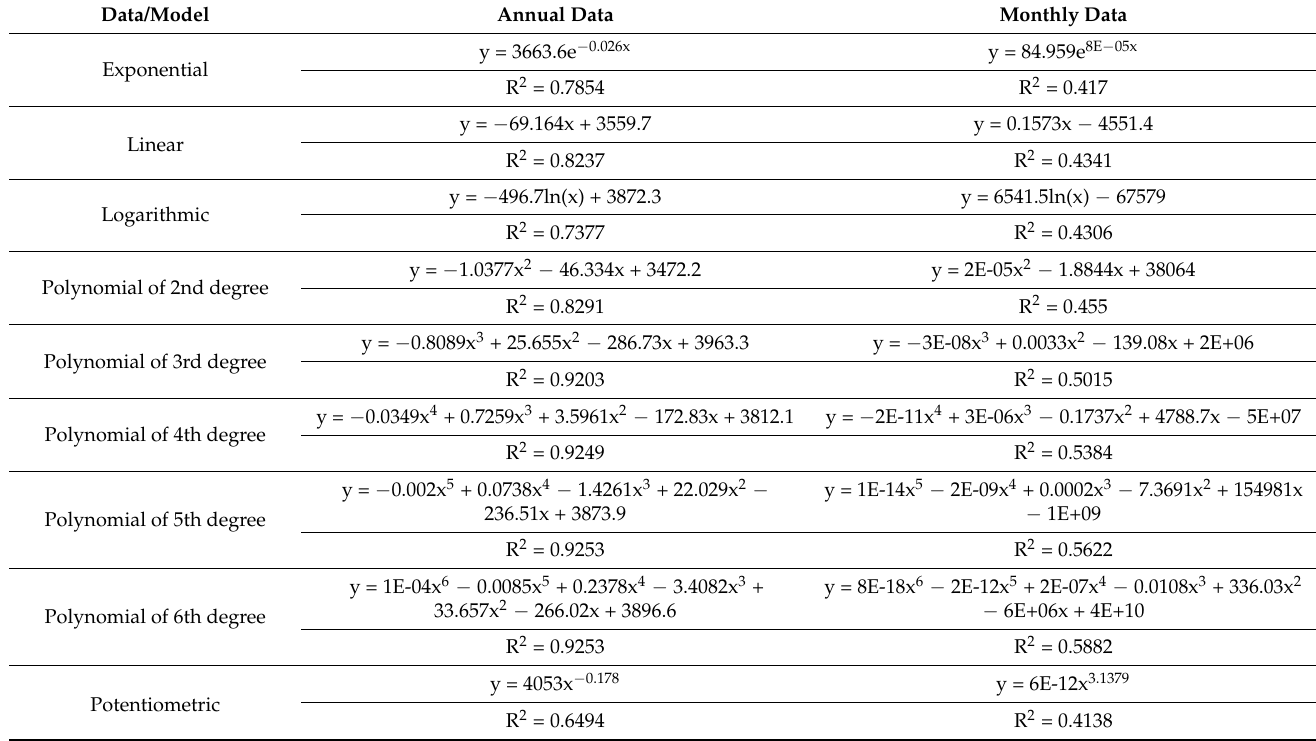
Table A11. Trend models for Pomeranian